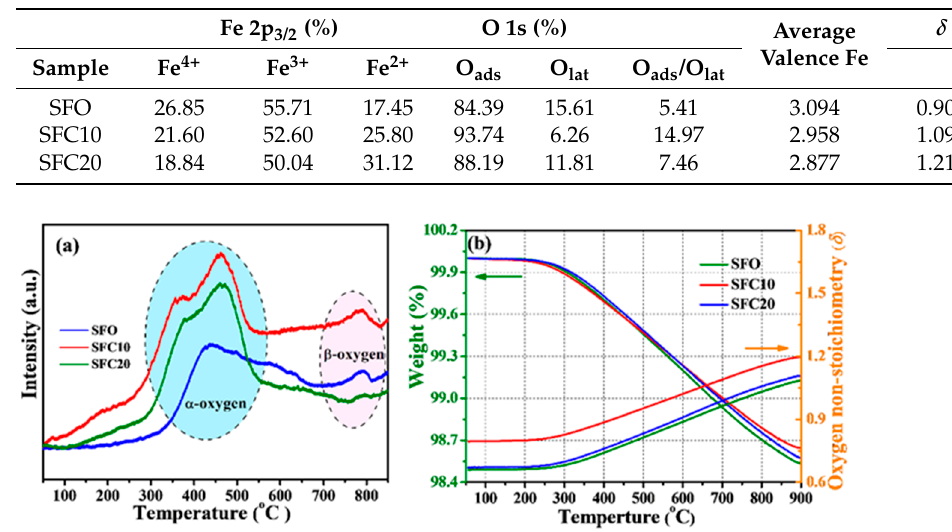
Figure 3. ( a ) O 1s and ( b ) Fe 2p 3/2 spectra of SFC x samples. Table 1. Percentages of different iron and oxygen, ratios of O ads /O lat , average oxidation states of iron and the oxygen non-stoichiometry.